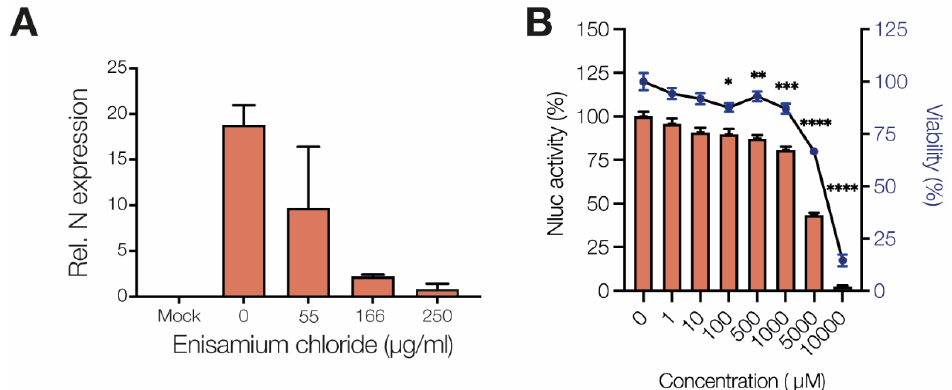
Figure 2. Enisamium inhibits HCoV-NL63 infection of NHBE cells and SARS-CoV-2 nsp12/7/8 activity in vitro. ( A ) Quantification of HCoV-NL63 N mRNA levels in NHBE cells infected with HCoV-NL63 after treatment with enisamium chloride. ( B ). Inhibition of SARS-CoV-2 nsp12/7/8 RNA polymerase complex activity by ensamium as measured with a mini-genome assay. Quantification is from n = 3 independently prepared reactions using the same nsp12/7/8 protein preparation. Error bars represent standard deviation. * p < 0.05, ** p < 0.01, *** p < 0.001, **** p <